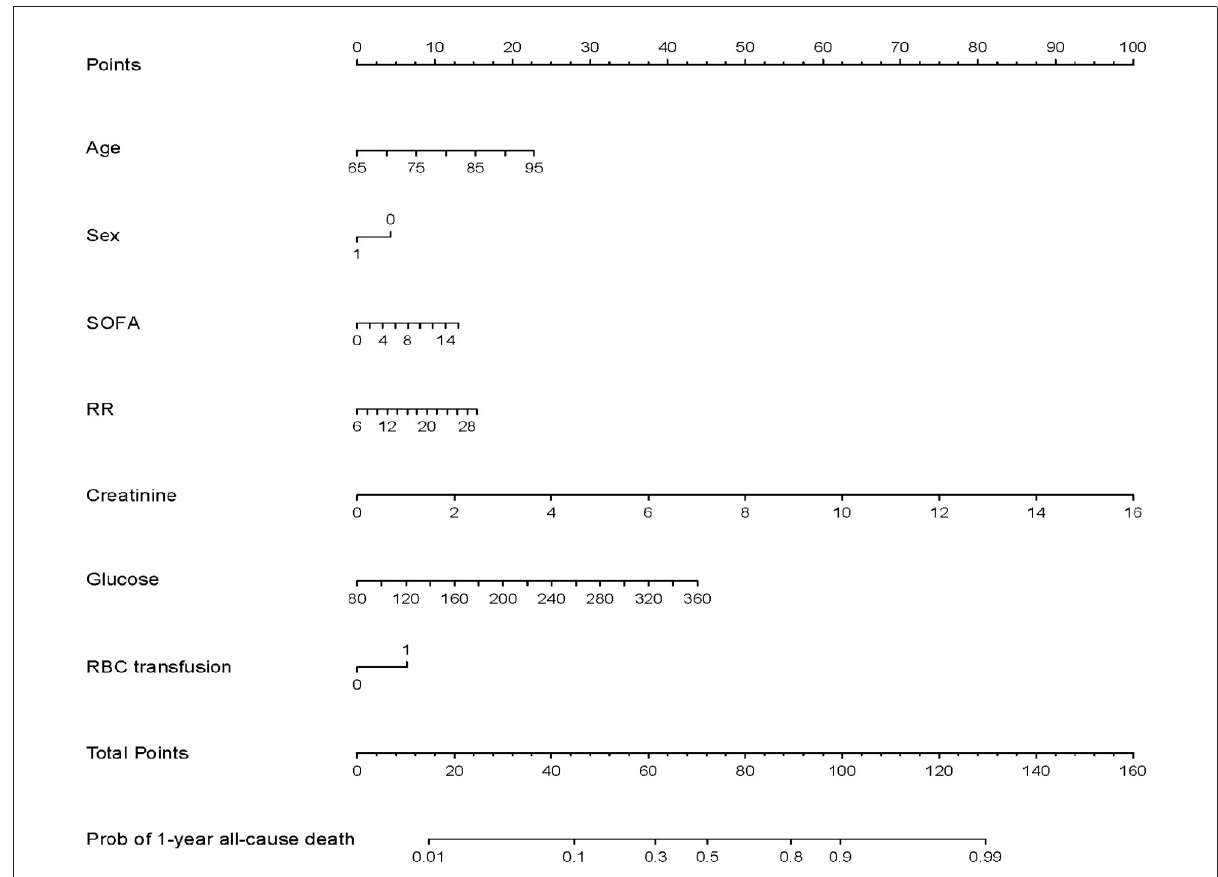
FIGURE3 Nomogram model for predicting 1-year all-cause mortality in elderly patients with cardiac